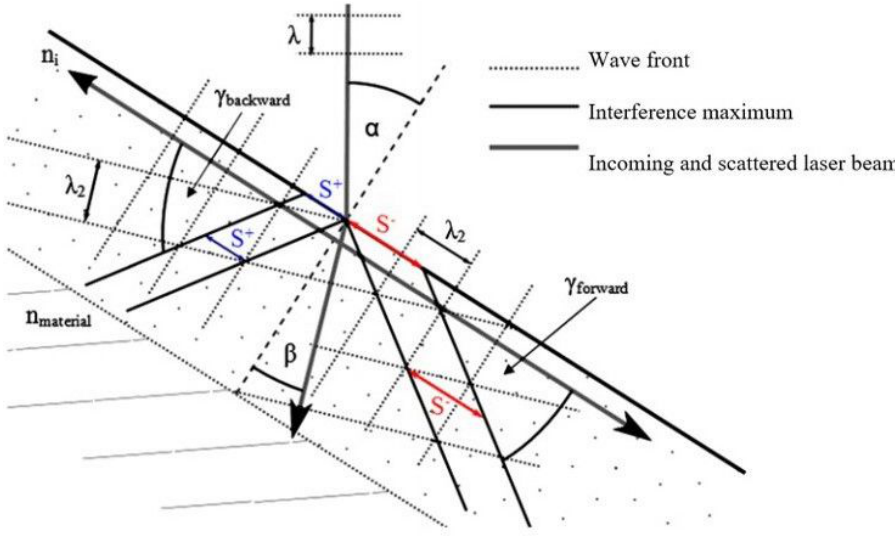
Figure 4: Scheme of the “surface scattered wave”